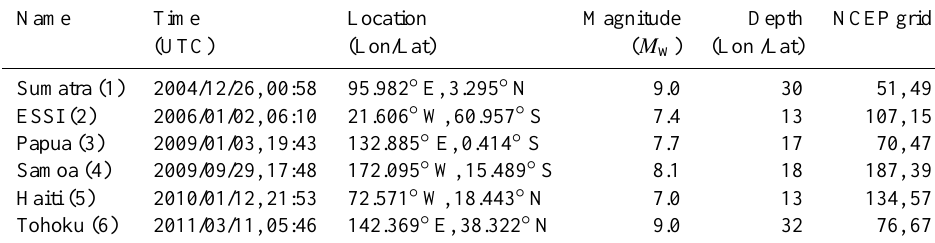
Table 1. Basic information of studied earthquakes.